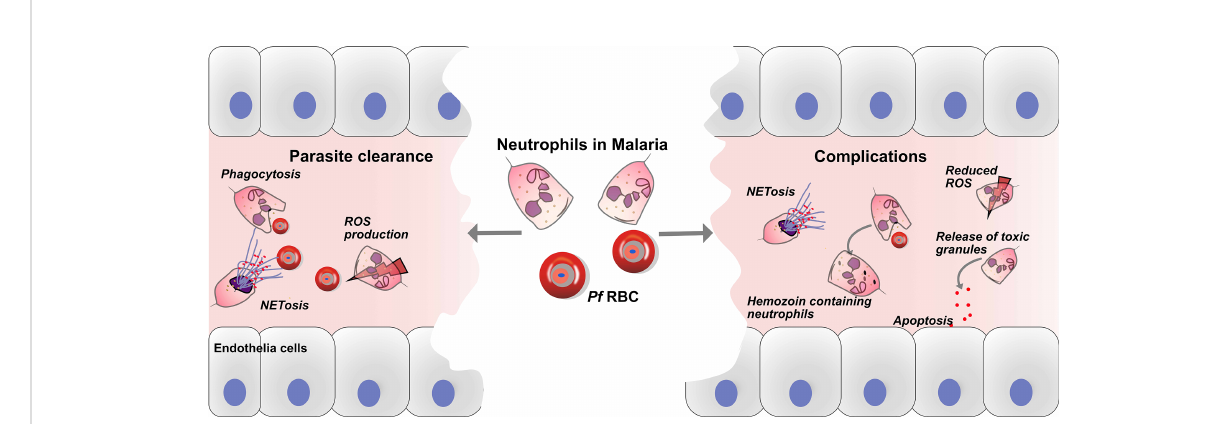
FIGURE 1 Roles of neutrophils in defense and pathology of malaria. Neutrophils play crucial roles in the immune defense against malaria, through parasite clearance via neutrophil phenotypic functions such as phagocytosis, reactive oxygen species (ROS) production and NETs release. On the other hand, neutrophils might play a role in the development of malaria complications, and haemozoin-containing neutrophils are associated with malaria severity. In addition, the release of toxic granules, such as myeloperoxidase (MPO), neutrophil elastase (NE) and matrix